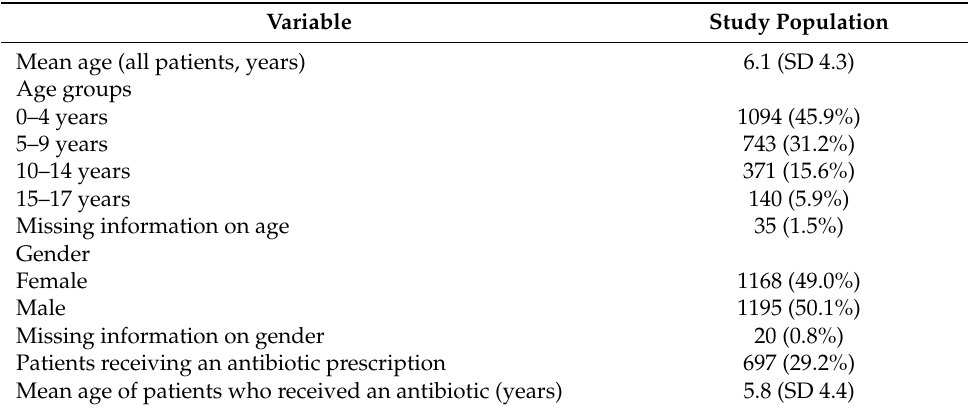
Table 2. Characteristics of the studied population and those patients treated with antibiotics.